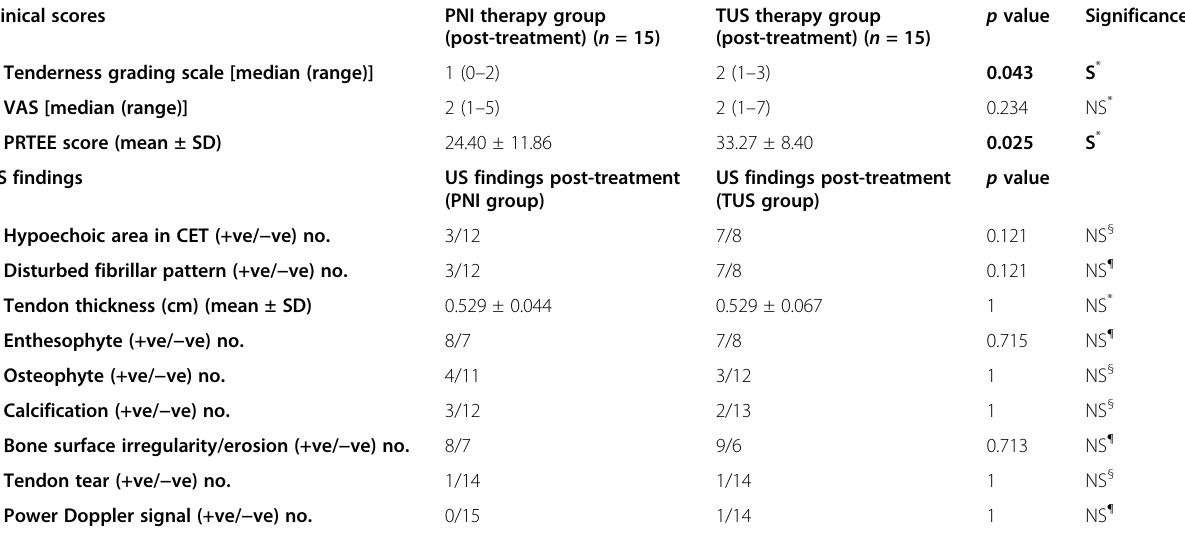
Table 5 Comparison of tenderness grading scale, pain intensity measured by VAS scale, PRTEE score, and US findings after treatment in both groups Clinical